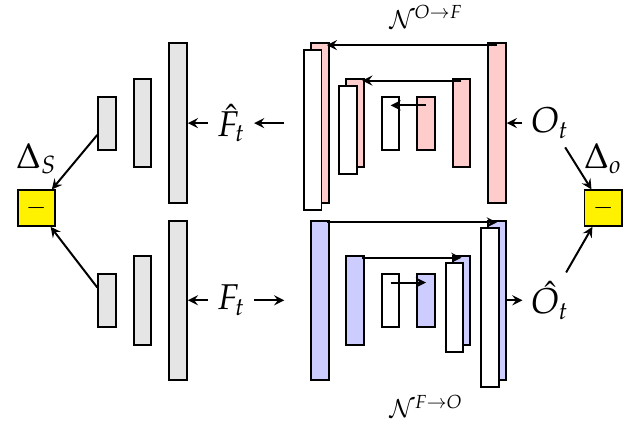
Figure 9. The cross-channel prediction conditional GAN architecture in [73]. There are two GAN models: flow → RGB predictor ( N O → F ) and RGB → Flow predictor ( N F → O ). Each of the generators shown has a U-net architecture which uses the common underlying structure in the image RGB channels and optical flow between two